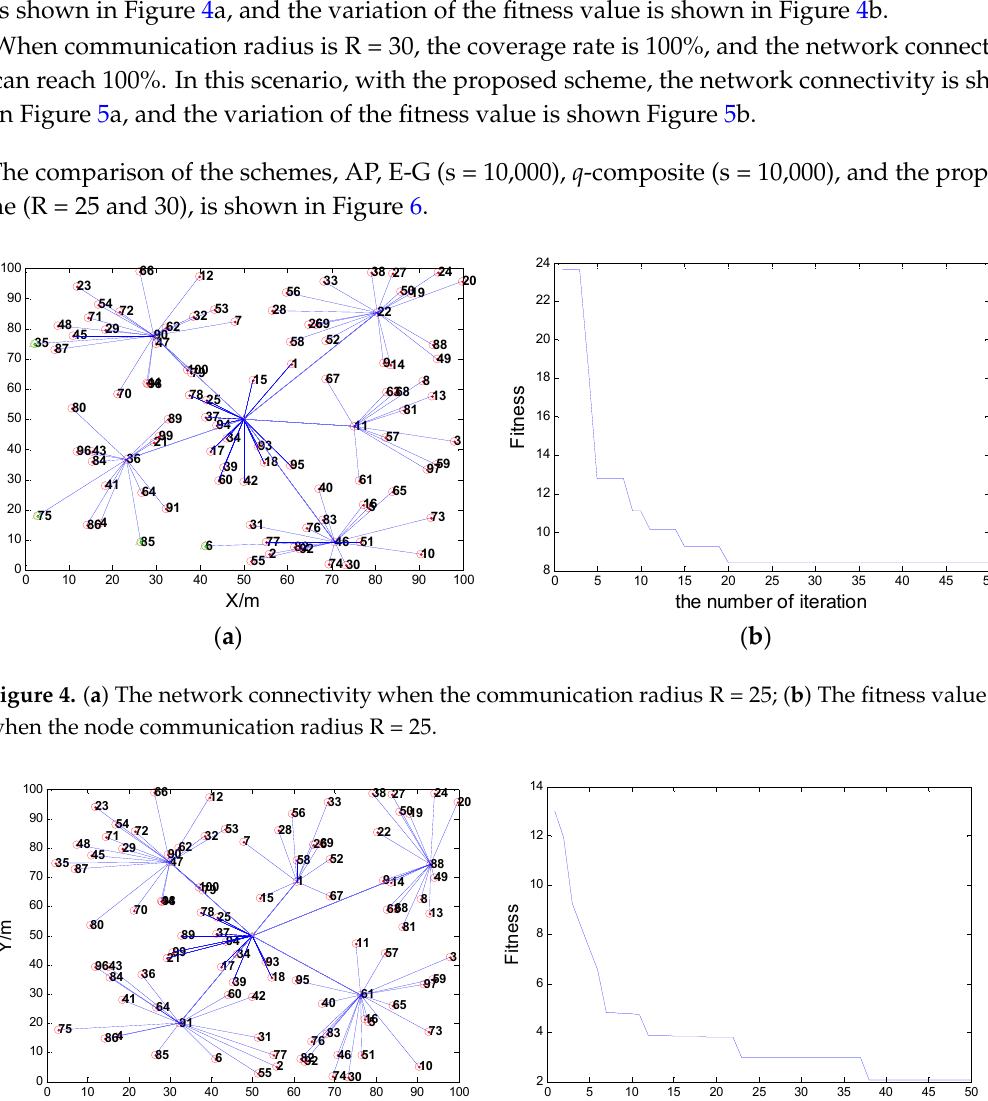
Figure 6. The comparison of network connectivity among the schemes of AP, E-G (s = 10,000), q - composite (s = 10,000), and the proposed scheme (R = 25 and 30). We can conclude from above, with the same number of keys stored in the nodes, the proposed scheme has higher keys connectivity efficiency compared with the E-G scheme, q -composite scheme, and the AP scheme. 4.2. Keys Storage Overhead After completing the process of establishing a session key, a cluster head needs to store some keys: cluster key, a pair of public and private keys of the cluster head, the public keys of all nodes in the cluster, the session keys with all nodes in the cluster, and the session key with the MS. A member node also needs to store some keys: cluster key, a pair of public and private keys of itself, and the session key with the associated cluster head. Therefore, the total storage overhead is 4